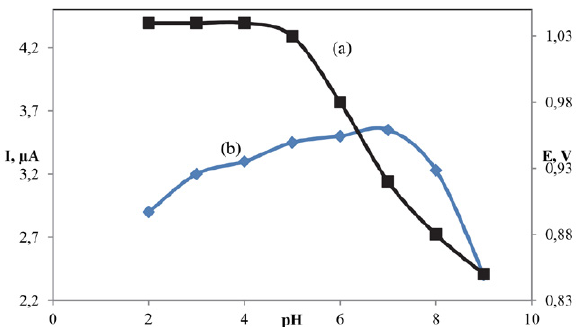
Figure 3. Dependence of peak potential ( a ) and peak current ( b ) on The pH of 0.1 mM SLC. The scan rate is 100 mV s –1